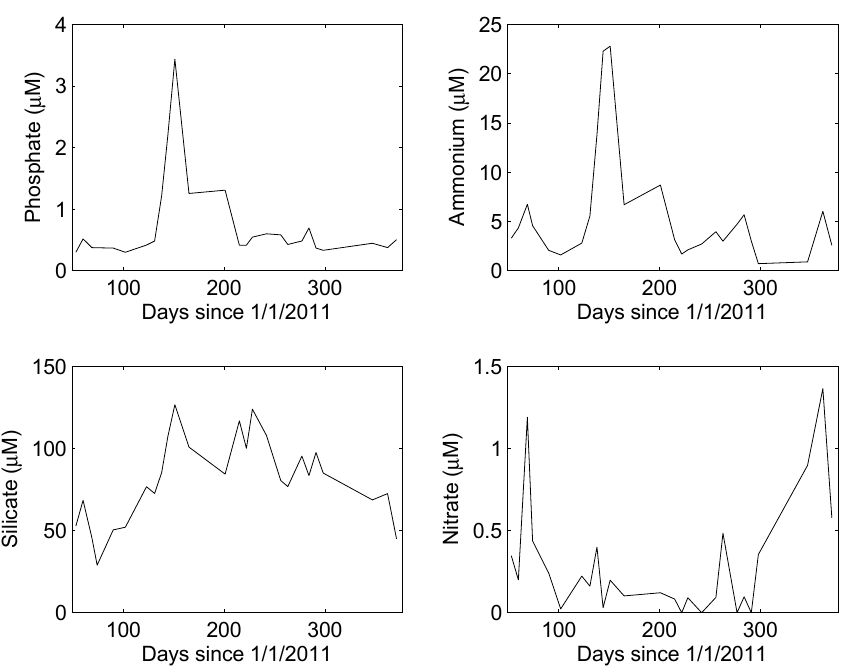
Figure 2. Median concentrations of inorganic nutrients under non-episodic conditions. In each case, a runs test revealed the time series to be significantly non-random ( p < 0.05).